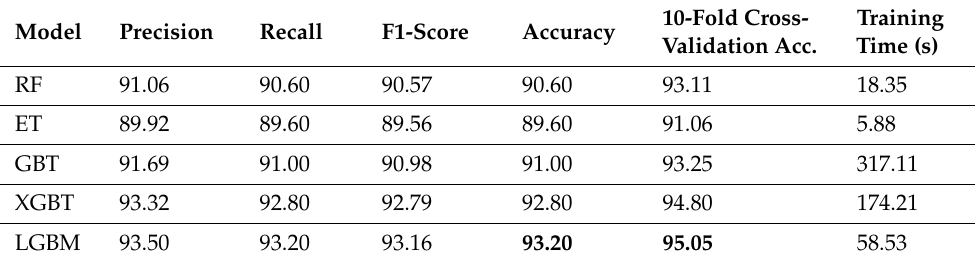
Table 8. Results on the test set with 80 packets as